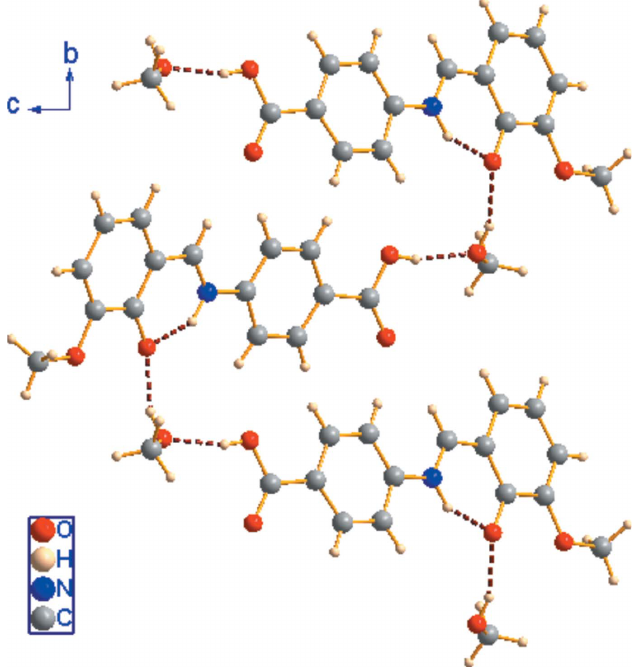
Figure 2 A view of the hydrogen-bonded chain extending along the b- axis direction. Hydrogen bonds are shown as dashed lines.